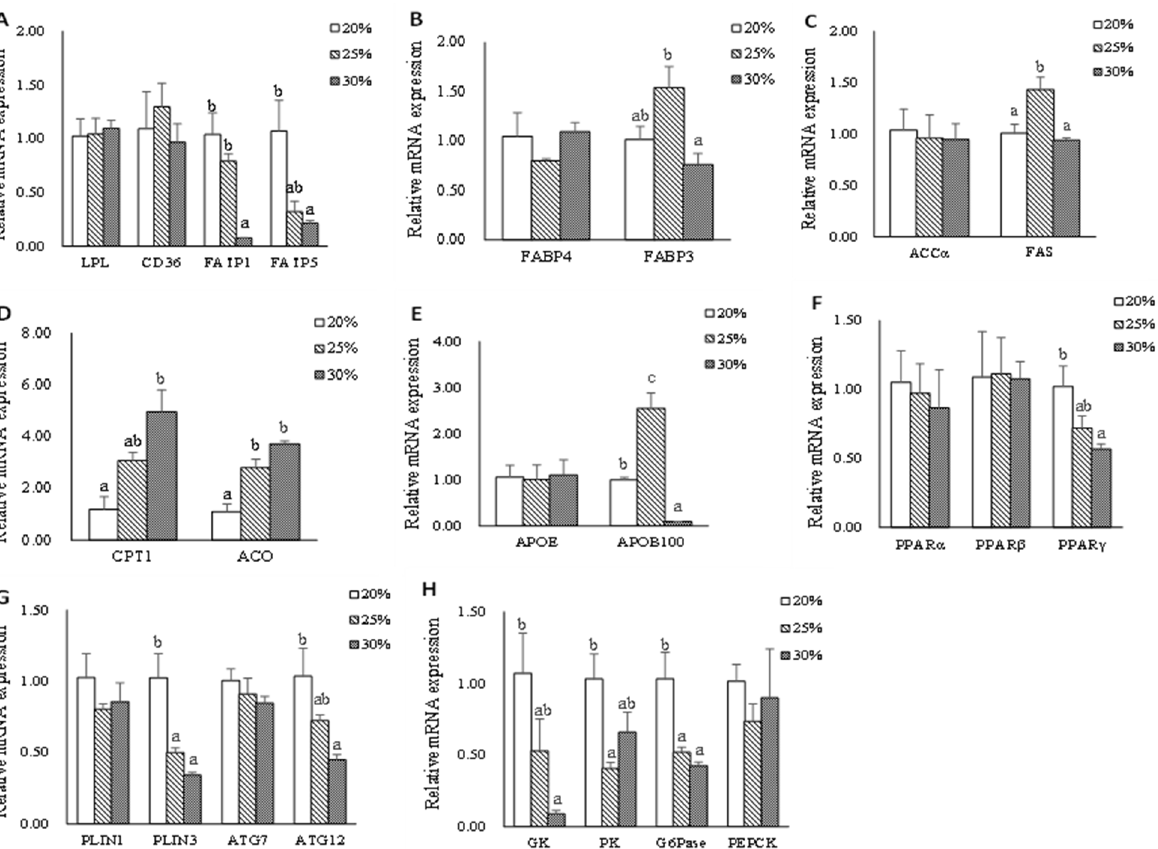
Figure 2. The mRNA expression of genes related to lipid metabolism in hepatic of triploid rainbow trout fed with diets containing low (20%), medium (25%), and high (30%) lipid content for 77 days. ( A ) The relative mRNA abundance of lpl , cd36 , fatp1, and fatp5 shows the ability of lipid uptake. ( B ) The relative mRNA abundance of fabp3 and fabp4 shows the activity of intracellular FA transport. ( C ) The relative mRNA abundance of acc α and fas shows the FA biosynthetic activity de novo. ( D ) The relative mRNA abundance of cpt1 and aco shows the activity of FA β -oxidation. ( E ) The relative mRNA abundance of apoE and apoB100 which are important components of VLDL. ( F ) The relative mRNA abundance of ppar α , ppar β , and ppar γ in the liver. ( G ) The relative mRNA abundance of plin1 , plin3 , atg7, and atg12 in the liver. ( H ) The relative mRNA abundance of gk , pk , G6Pase, and pepck in the liver. Values are expressed as the means ± S.E.M. (n = 3). Statistical significance was evaluated using one-way ANOVA, followed by Tukey’s test. Values with different letters on columns statistically differ at p < 0.05.